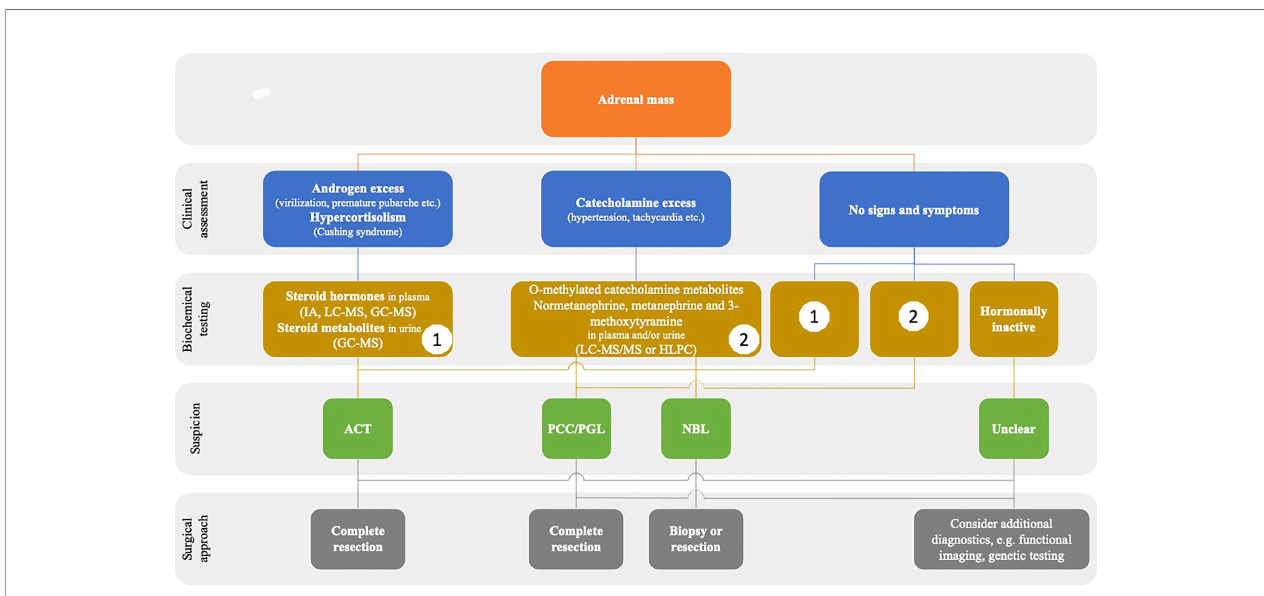
FIGURE 2 | Flowchart showing the diagnostics steps in children presenting with an adrenal mass in imaging. GC-MS, gas chromatography-mass spectrometry; IA, immunoassay; LC-MS, liquid chromatography-mass